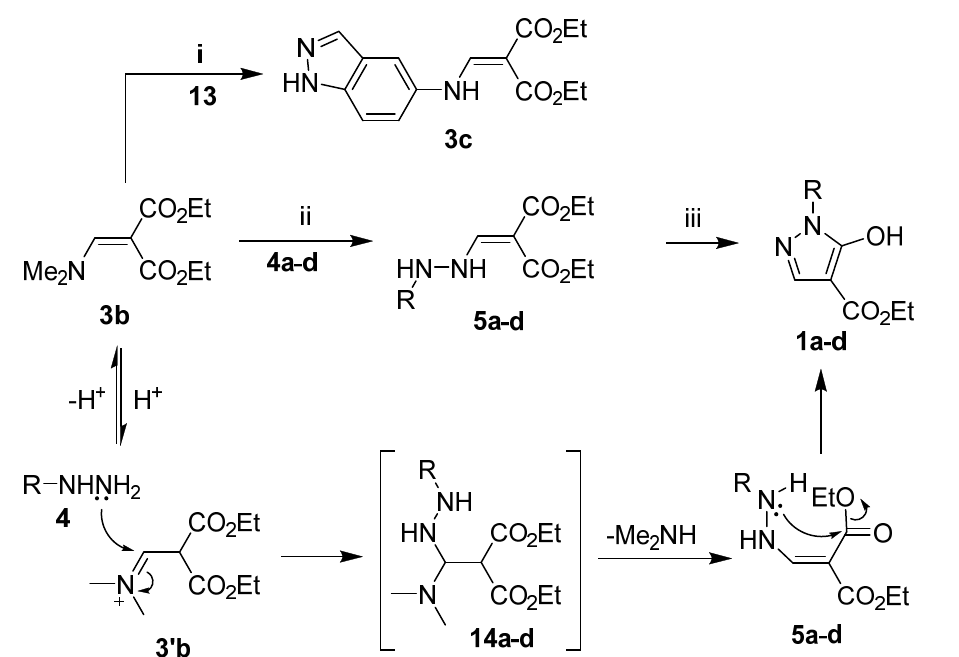
Scheme 2. Synthesis of compounds 1a – d , 3c , and 5a – d . Reaction conditions: (i) 1 H -indazol-5-amine